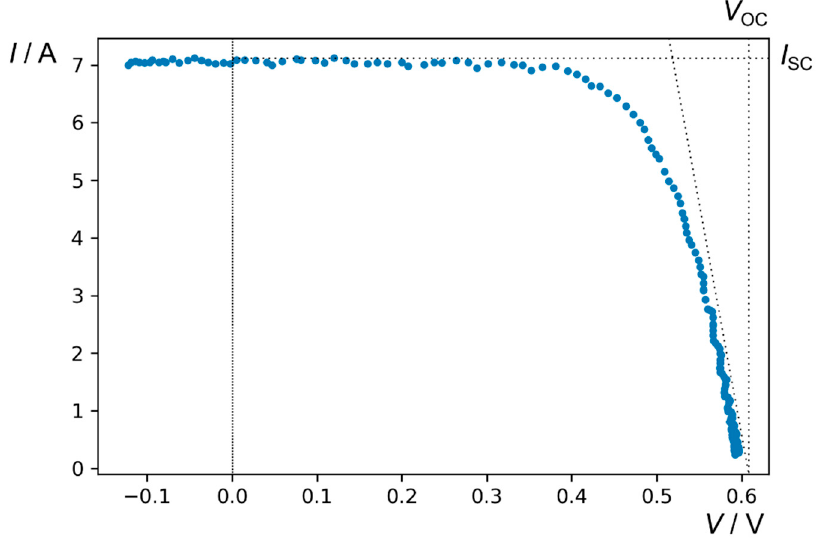
Figure 18. The I-V curve of a real cell with the device and the platform proposed for irradiance of 750 W/m 2 .